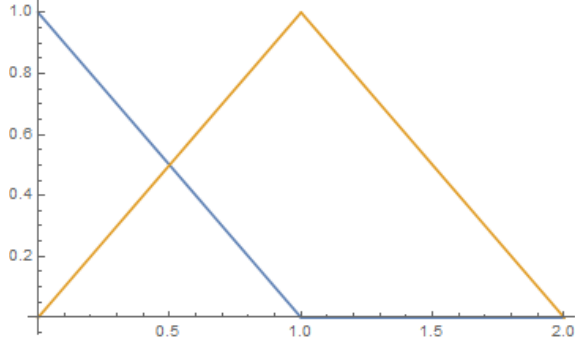
Figure 2. The left-edge function N 01 (blue) and the linear cardinal B-spline B 1